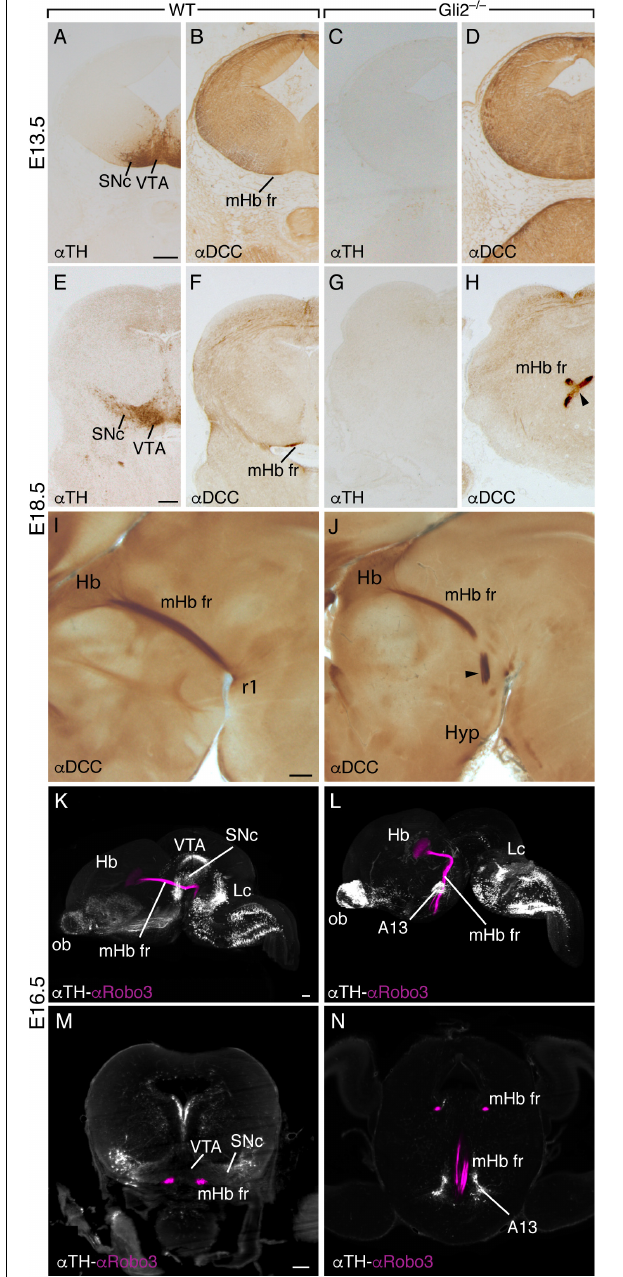
FIGURE 2 | Drastic alteration in the fr trajectory in the Gli2 − / − mutant. Transversal sections of wild-type E13.5 (A,B) and E18.5 (E,F) brains and Gli2 − / − E13.5 (C,D) and E18.5 (G,H) brains labeled against TH and DCC. In the wild type, the SNc and VTA are identified as well as the mHb fr in the pial surface. In the mutant, the SNc is not detectable (C,G) , and the fr is misoriented and crosses the midline in an abnormal position (arrowhead in H ). Sagittal sections of wild-type (I) and Gli2 − / − (J) E18.5 brains labeled against DCC. In the wild type, the mHb fr is observed in all its length, from the Hb into r1. In the mutant brain, we detected the fr abnormal rostral bending into the hypothalamic territory. In this mutant model, the SNc and VTA are not generated. The mHb fr displayed an abnormal trajectory into rostral